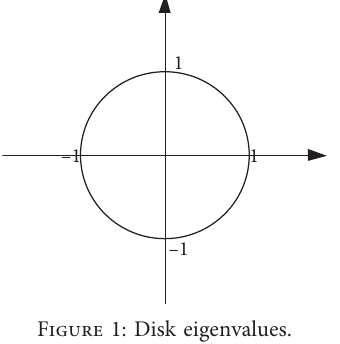
Figure 1: Disk eigenvalues.